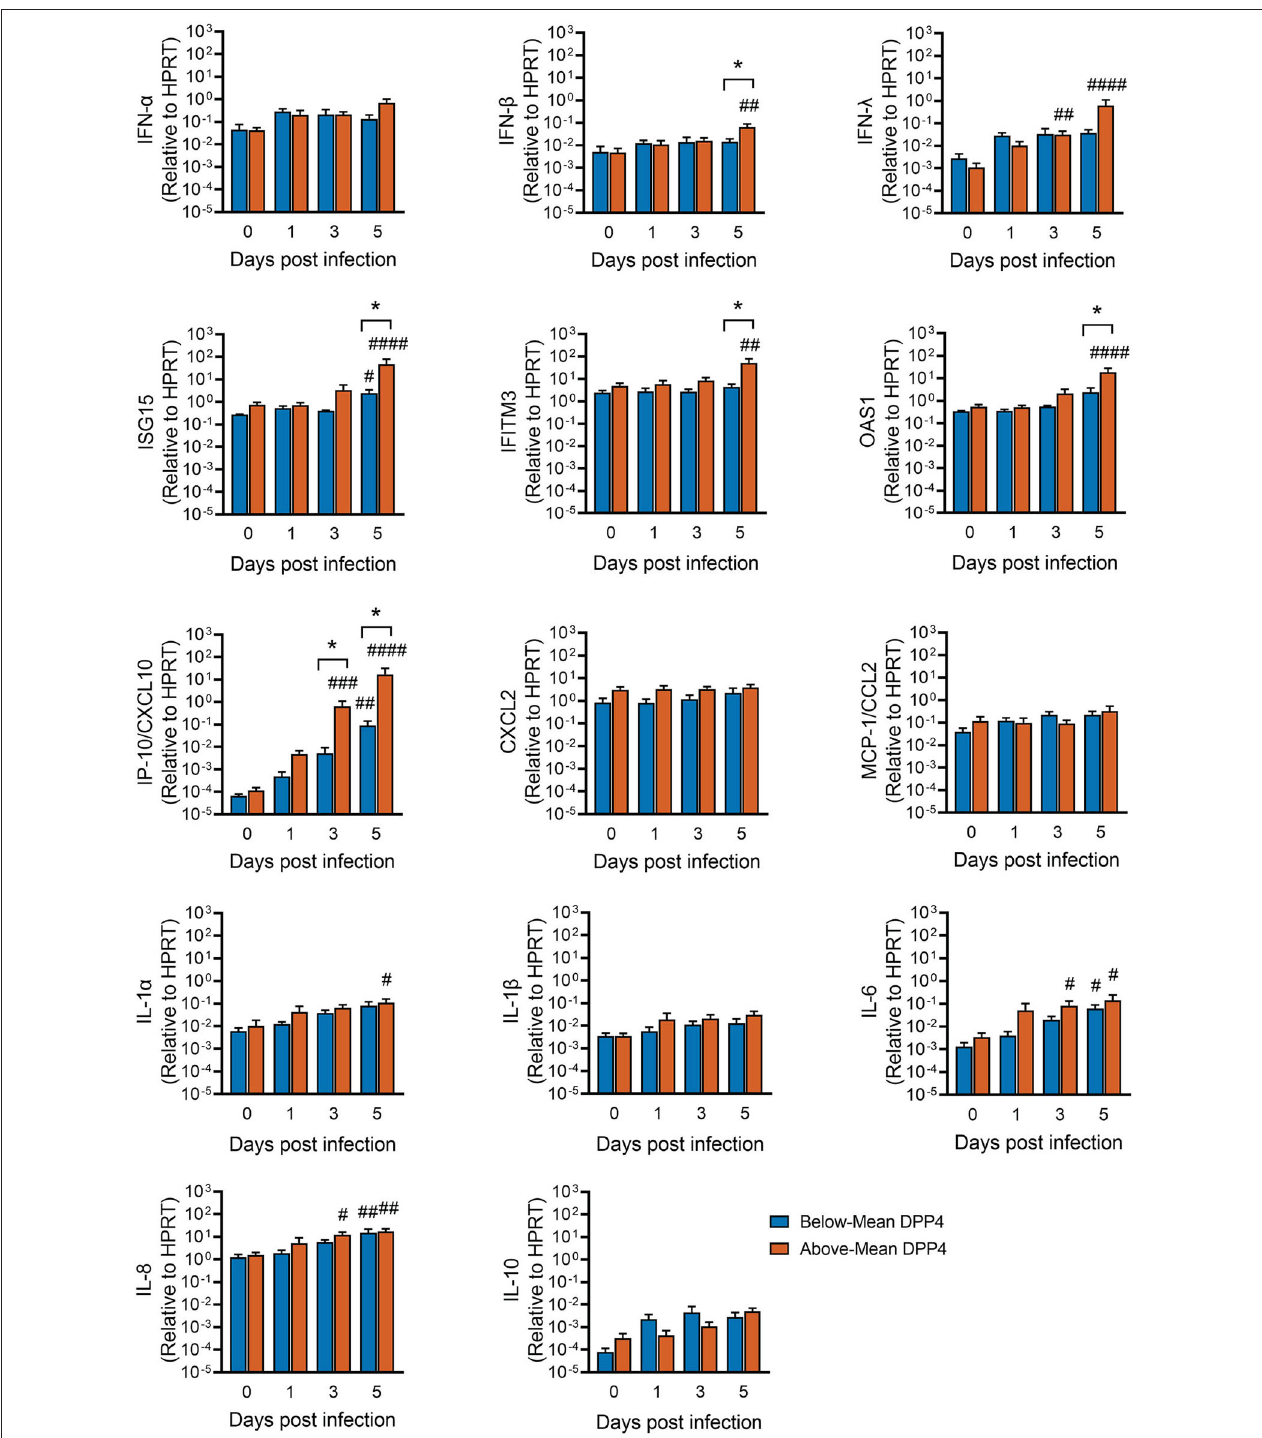
FIGURE 5 | Innate immune responses following MERS-CoV infection and relationship to DPP4 abundance. HAE were infected apically with MERS-CoV (MOI = 0.1) and total RNA isolated at the indicated time points for qRT-PCR analysis. For each gene, mRNA abundance was normalized to that for HPRT. Above-Mean DPP4 group, n = 4; Below-Mean DPP4 group, n = 4. Data represent mean ± SE. One-way ANOVA, followed by Sidak’s multiple comparisons test, was used to test log transformed data for significant differences relative to the corresponding uninfected control cells (Day 0) within each group. # P adj < 0.05, ## P adj < 0.01, ### P adj < 0.001, #### P adj < 0.0001. To test for significant differences between the Above- and Below-Mean groups at each time point post infection, log transformed data were tested by unpaired 2-tailed t -tests * P < 0.05.